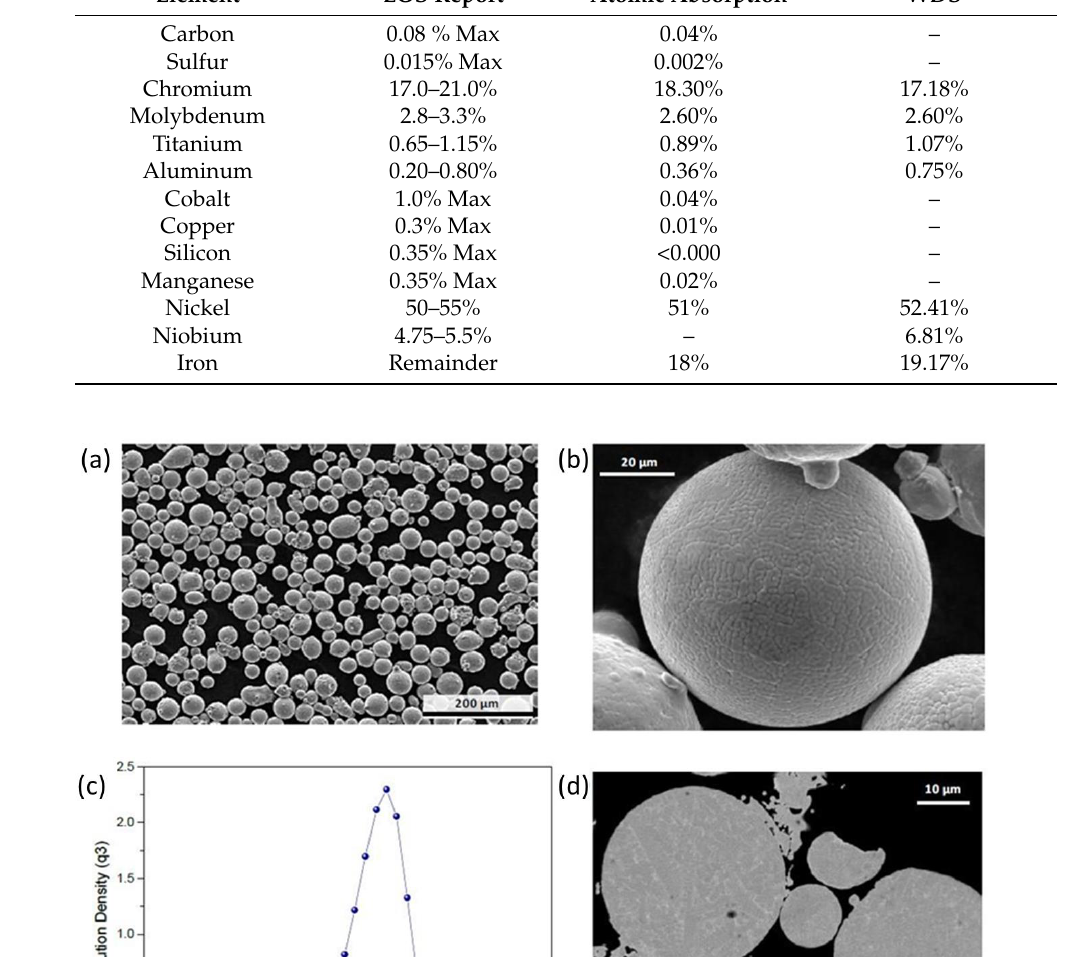
Table 1. IN718 powder composition obtained from different analysis methods.